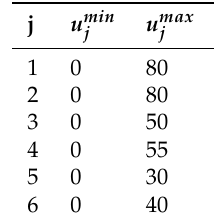
Table 2. Values used for constraint set.